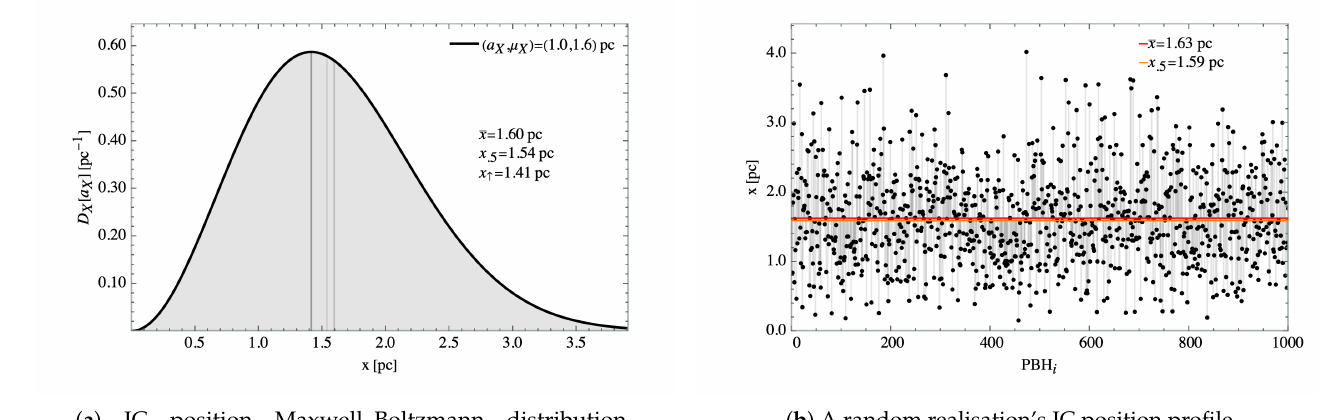
Figure 3. Position IC profile from Table 1 and an example realisation, from the mean µ x = 1.6pc and scale parameter a x = 1.0pc. The thick, normal and thin grey lines signal the distribution mode, median and mean, respectively. The orange and red lines signal the realisation median and mean, respectively. To to obtain the radial position abundance one needs only to multiply the previous distribution by the surface element dS = 4 π x 2 , which enhances the tail. Note the hierarchy between modal, median and mean masses is much reduced with respect to the mass case, due to the smallness of the x → ∞ tail of the distribution, which results in a small variance of the total simulated volume covered in the